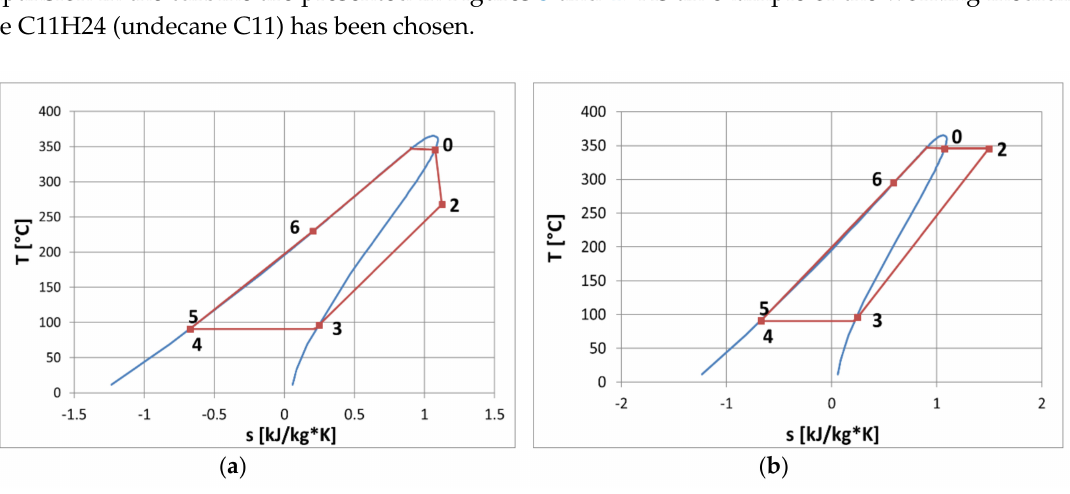
Figure 3. Interpretation of Variant 1 for adiabatic ( a ) and isothermal ( b ) expansion (working medium: undecane-C11); where: limit line—red and cycle—blue line.